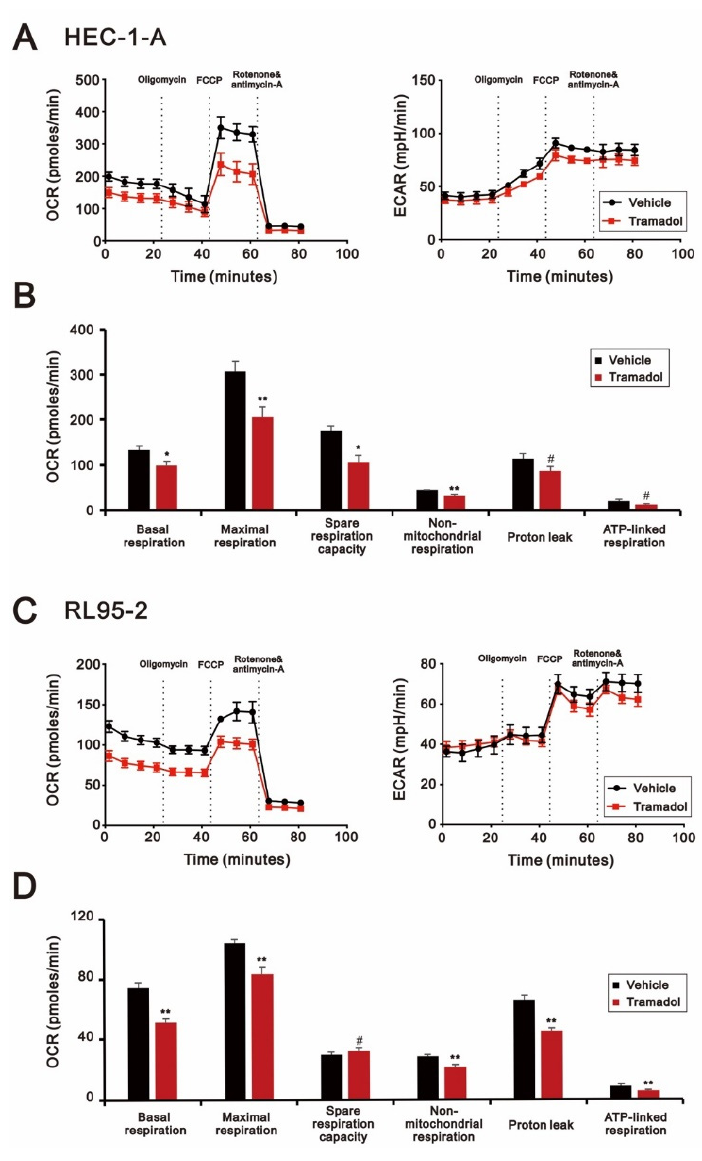
Figure 7. Effects of tramadol on mitochondrial function of human endometrial cancer cells. ( A , B ) HEC-1-A and ( C , D ) RL95-2 cells were treated with tramadol (0 and 1 mg/mL) for 4 h. ( A – D ) OCR and ( A , C ) ECAR were assessed using seahorse XFp analyzers. Bars depict the mean ± SD of three independent experiments. Student’s t -tests were performed, and the results were compared with the vehicle. # p > 0.05, * p < 0.05, ** p < 0.01 (Student’s t